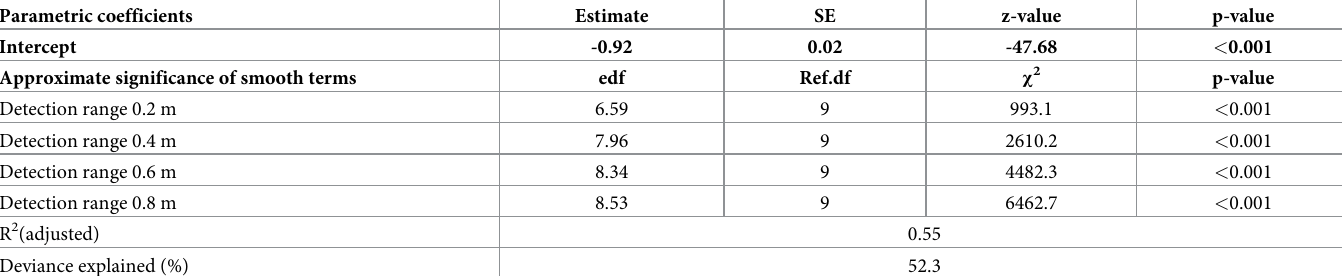
Table 2. Generalized additive model (GAM) summary table. edf = estimated degrees of freedom. Ref.df = reference number of degrees of freedom used for hypothesis testing.